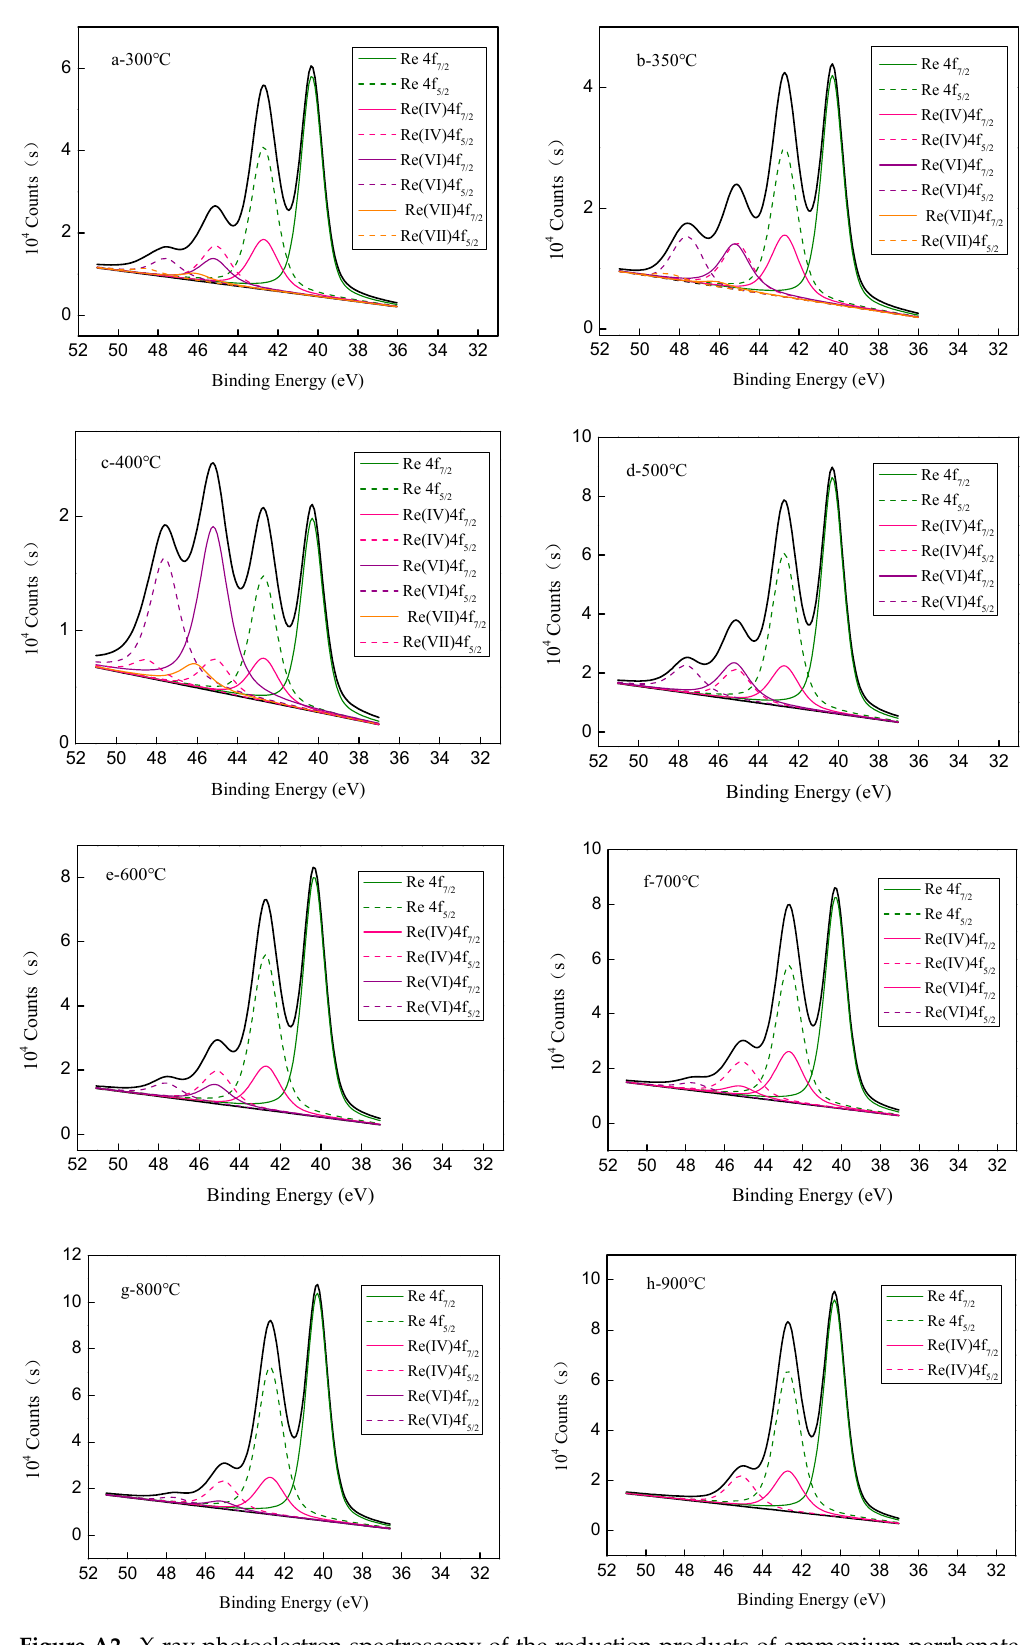
Figure A2. X-ray photoelectron spectroscopy of the reduction products of ammonium perrhenate (D 50 was 81.05 µm, specific surface was 21.72 m 2 /kg) at different temperatures.